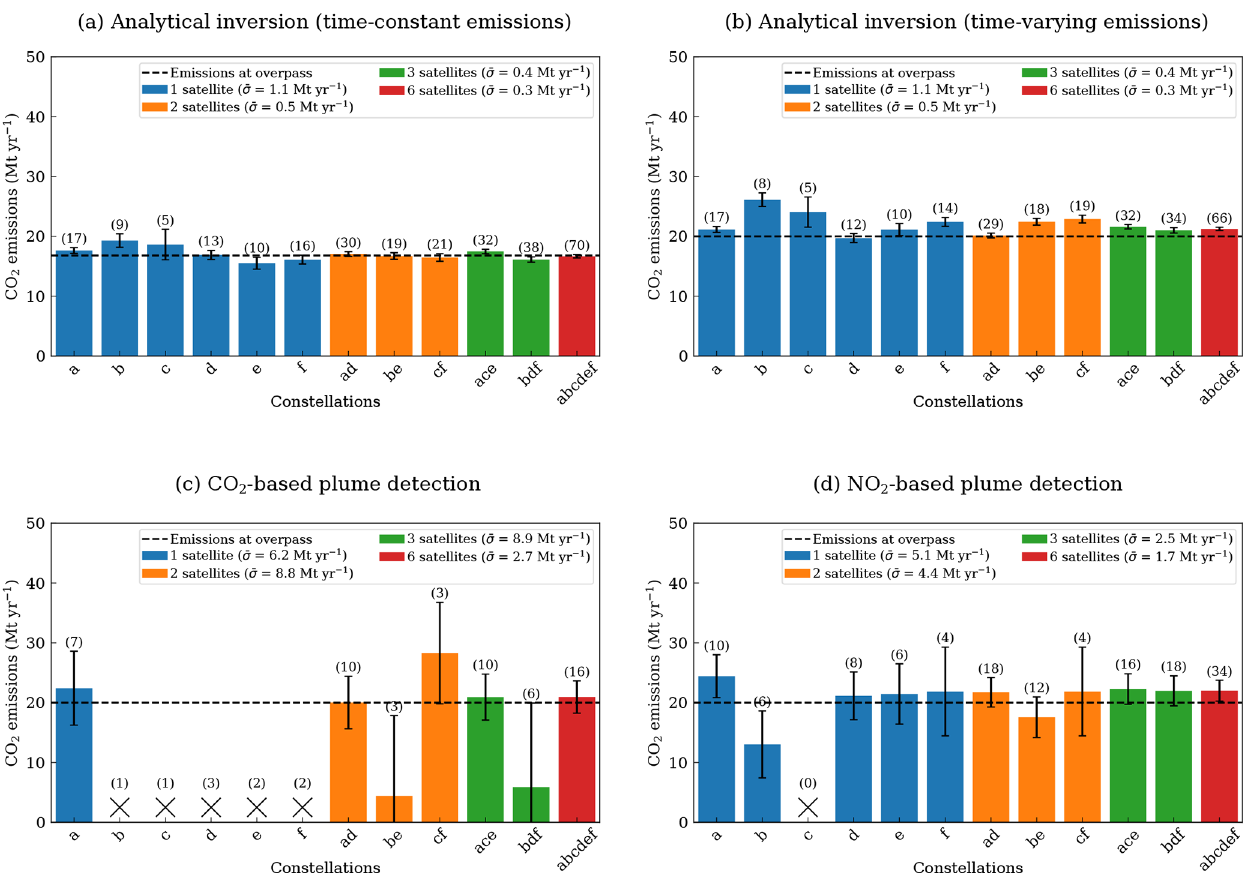
Figure 11. Estimated annual emissions at satellite overpass for (a) analytical inversion and (b) mass-balance approach with CO 2 -based plume detection and (c) NO 2 -based plume detection for different constellation sizes. The number of overpasses with estimated emissions are shown in brackets. If the number of estimated emissions is too small for computing the seasonal cycle, values are marked with a cross. Error bars show the precision computed from the individual emission estimates at satellite overpass. The legend shows the mean error for each constellation